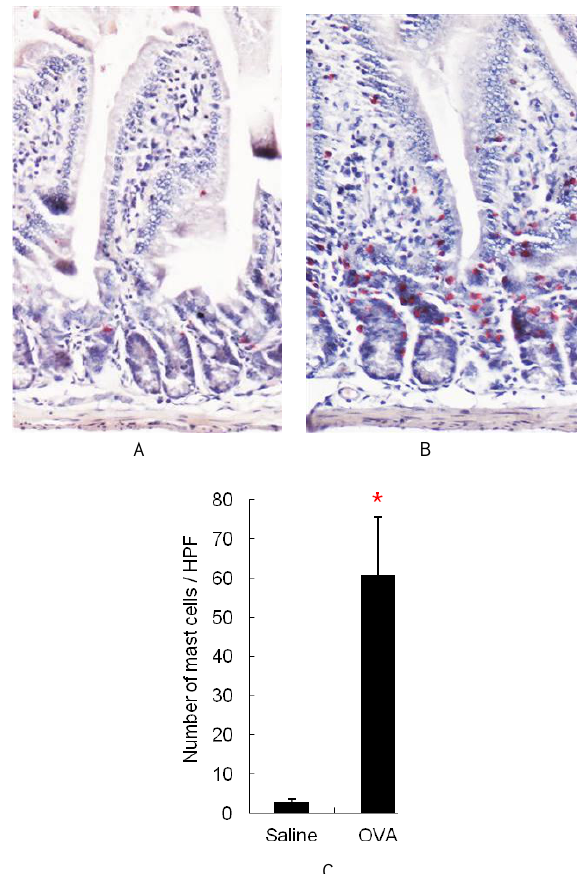
Figure 3. Mucosal mast cell responses. Representative fields (original magnification,  200) of saline-sensitized (A) or OVA- sensitized (B) jejunum sections stained with chloroacetate esterase. (C) Mast cell levels were calculated by Image-Pro Plus 6.0 software. (n = 5 mice/group; mean  SE; *